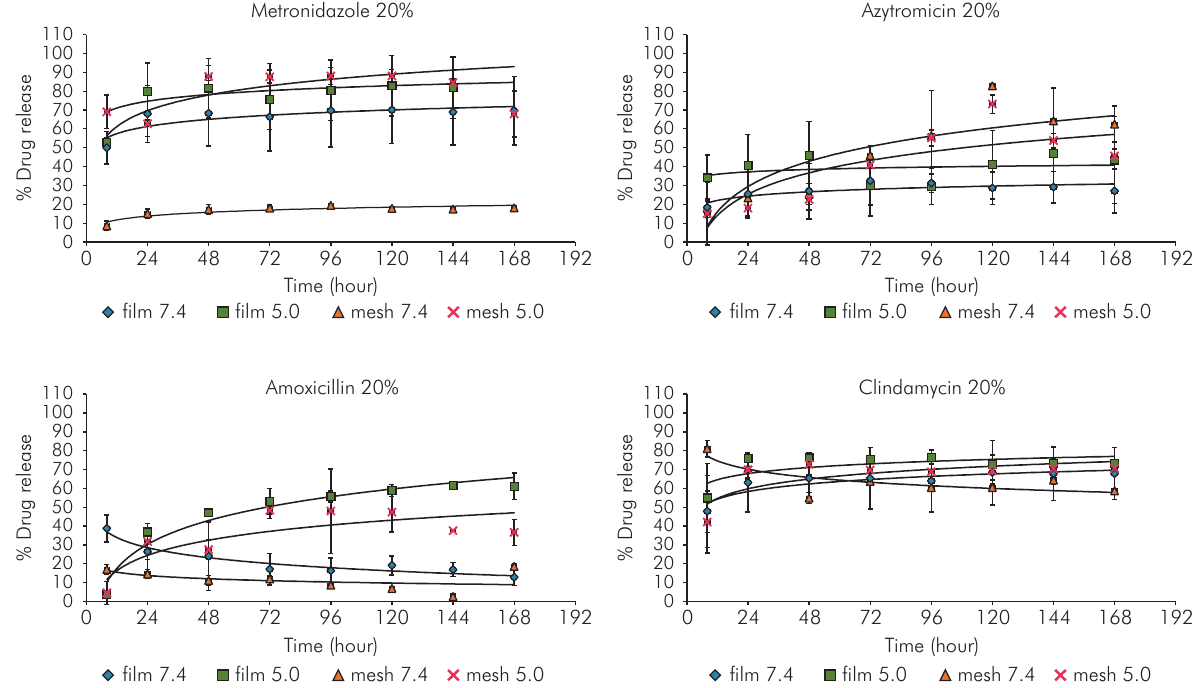
Figure 2. Drug release